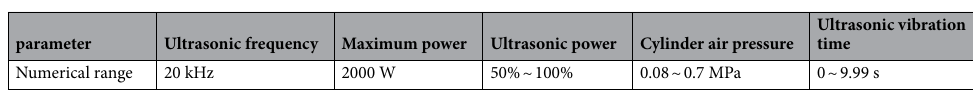
Table 1. Main parameters of ultrasonic plastic welder.